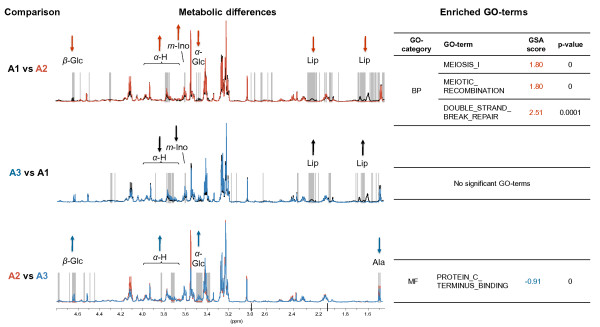
Differences in metabolic and gene expression profiles of identified groups of luminal A samples. Mean spectra of the A1 (black), A2 (red) and A3 (blue) groups of luminal A tumors are plotted with the significantly different points (p < 0.001) indicated with grey vertical lines. At ppm values with allocated metabolites and significant differences in one group versus the other, the direction of the arrows indicate if the latter group has the highest (up) or lowest (down) mean value. GO-terms that were significantly enriched (fdr < 0.01) in the different groups are indicated for each comparison, calculated using Gene Set Analysis (GSA) on the microarray data.